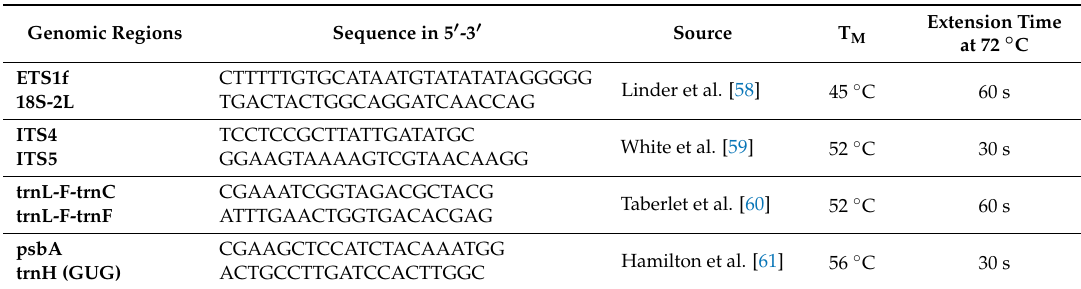
Table 5. List of primers, T M , and extension